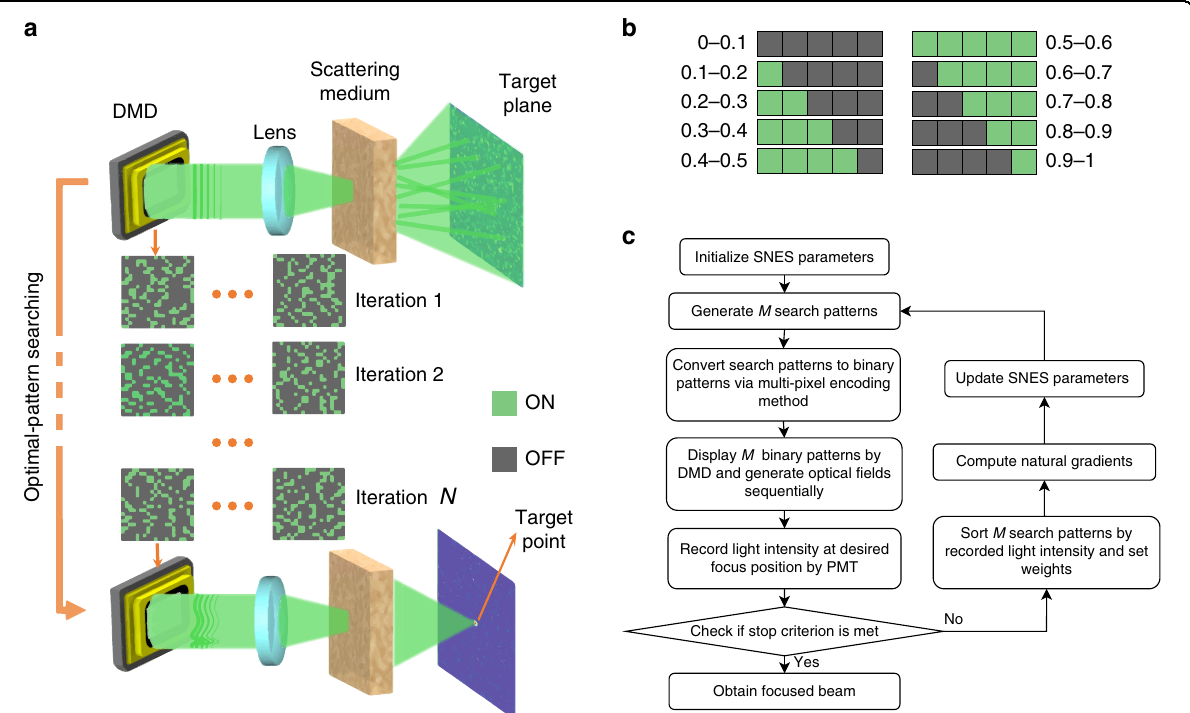
Fig. 1 Principle and schematic of mpDMD-SNES WS method. a Schematic of the iterative WS method; b Code of the multi-pixel DMD encoding strategy, where the number of encoded pixels is 5; c Diagram of